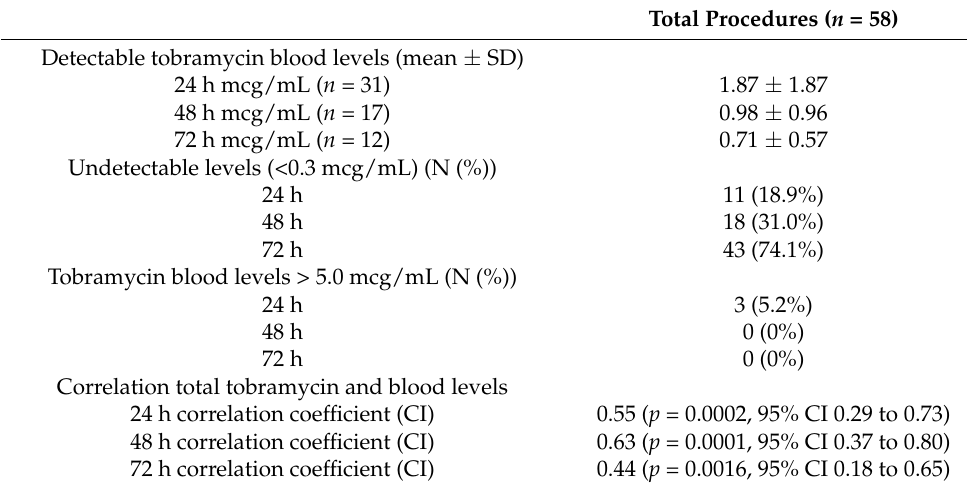
Table 3. Systemic tobramycin blood